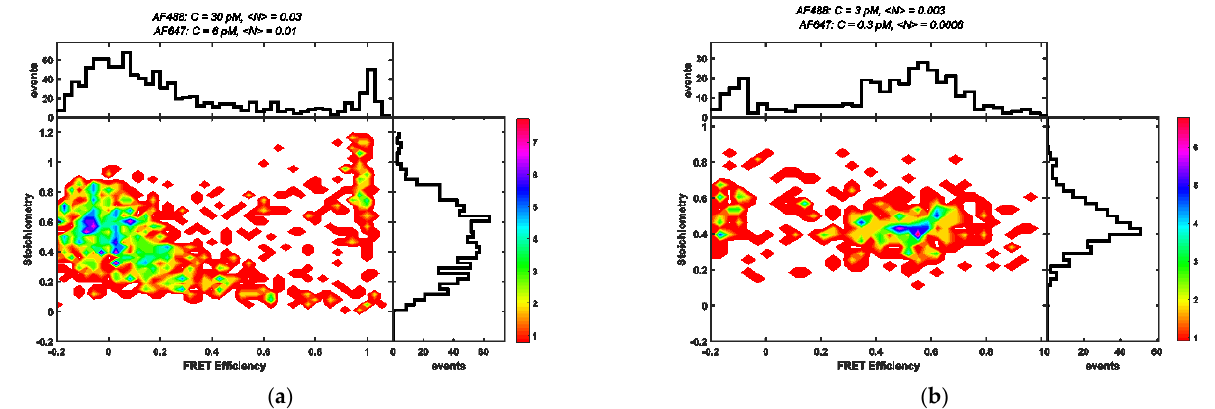
Figure 5. Here, stoichiometry versus FRET efficiency plots are shown for RNC samples as measured with different molecule or dye concentrations. ( a ) At higher concentrations, the corresponding FRET efficiency histogram (upper panel) showed only peaks at <E> ≈ 1 and <E> ≈ 0, which can be consid- ered as artifacts. ( b ) At lower concentrations, the corresponding efficiency histogram exhibited a meaningful FRET population at <E> ≈ 0.55, that represented the apo-CaM state. The color code gives the number of burst for each point in the S vs. E plane.